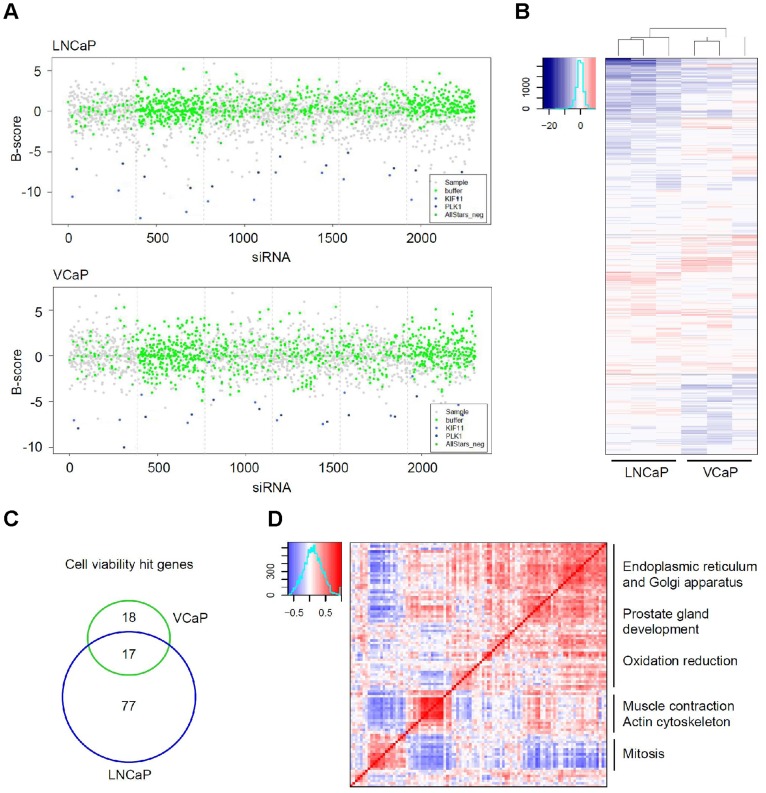
HT RNAi screening results.
A. Overview of the normalized LNCaP and VCaP cell viability screen results (B-score). The results from the positive control siRNAs (KIF11 and PLK1) are indicated in blue, negative control wells (AllStars negative scrambled siRNA and buffer only) in green, and target gene siRNAs in gray. B. A heatmap presentation of the cell viability screen results (B-score). The assay was repeated three times in both LNCaP and VCaP prostate cancer cell lines. Blue colour indicated decreased cell viability, red increased cell viability. The heatmap is drawn based on unsupervised hierarchical clustering. C. The overlap between the RNAi screen hit genes (decreased cell viability in response to silencing) in LNCaP and VCaP cell lines. D.
In silico co-expression analysis of cell viability hit genes in prostate cancer samples. The genes are organized in the same order in both y- and x-axis, and the correlations (R) between the genes are indicated with colours. Red indicates positive correlation, blue negative correlation.